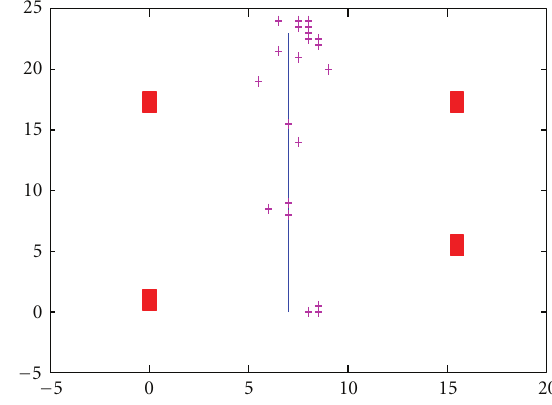
Figure 12: Localization error in the swimming pool.